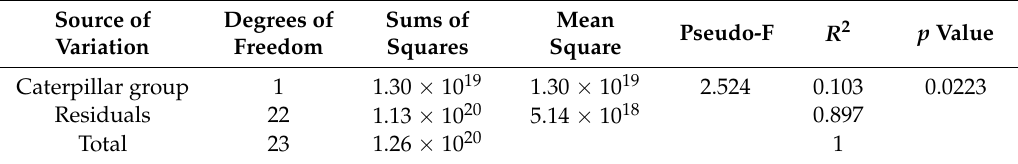
Table 2. Permutational multivariate analysis of variance (PERMANOVA) of the complete dataset of caterpillars (Caterpillar-Dataset) including the metabolomics and stoichiometric data with caterpillar group (C-iberica and C-nevadensis) as categorical independent